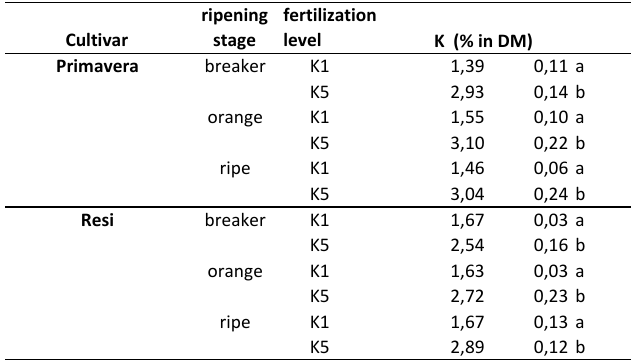
Table S6: Potassium values are differentially affected by fertilization in the two cocktail tomato cultivars grown in 2015.